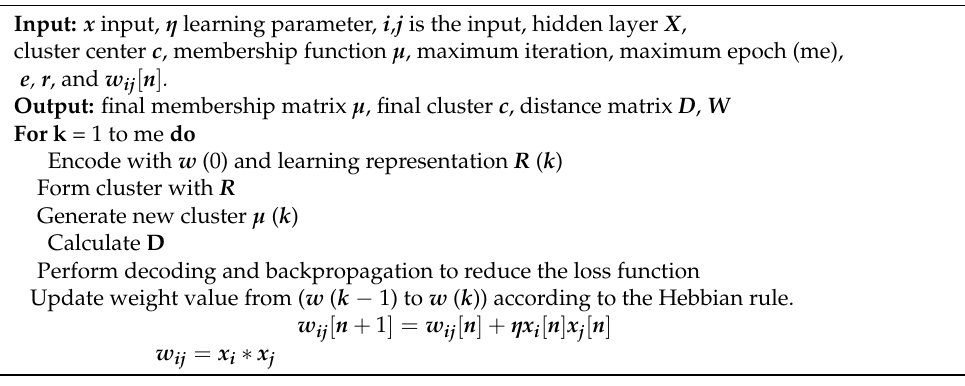
Algorithm 1 DBN-HBL-based Clustering